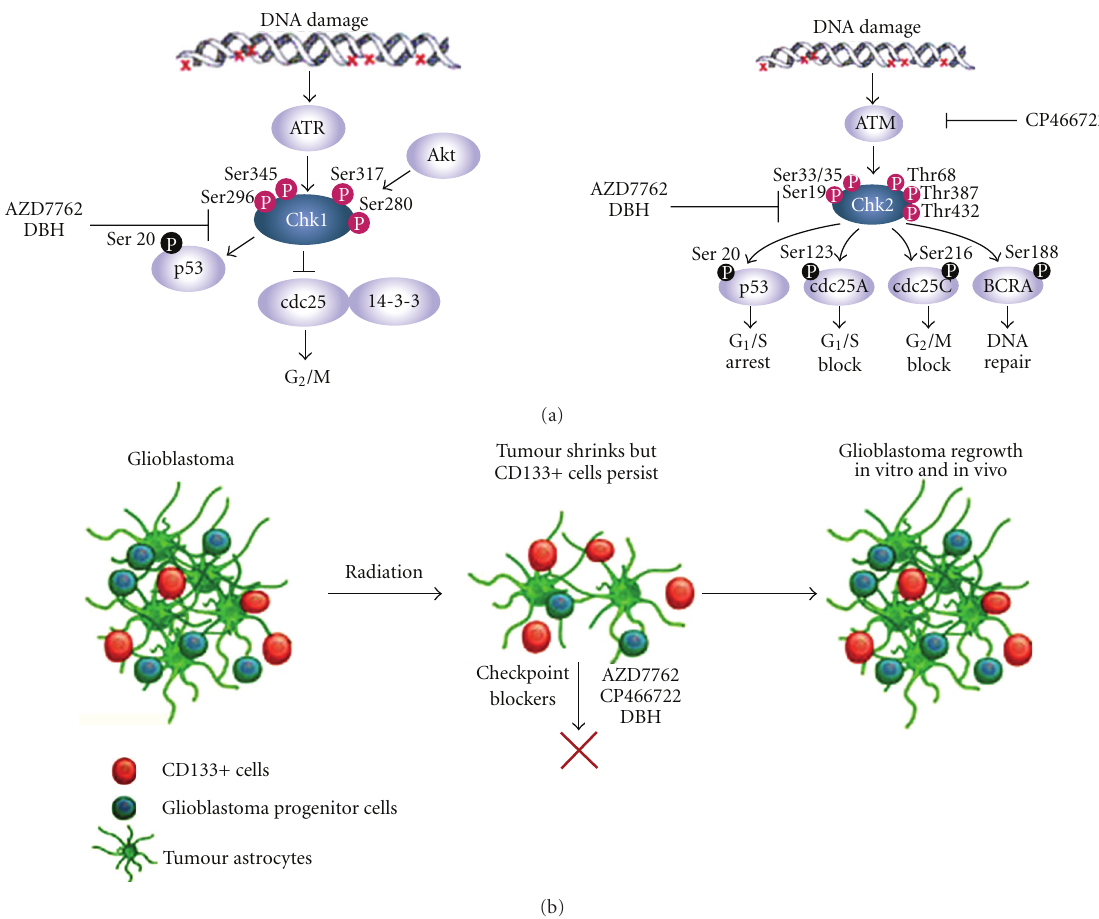
Figure 3: Cell cycle checkpoint pathways, possible targets in GSC. (a) Once DNA damage is identified with the aid of sensors, the checkpoint transducers ATM and ATR undergo conformational change and/or localisation, resulting in their activation. ATM and ATR activate a series of downstream molecules, including the checkpoint kinases Chk1 and Chk2. The latter inactivate CDC25 phosphatases, culminating in cell cycle arrest. AZD7762 (AstraZeneca) and DBH are specific inhibitors of Chk1 and Chk2 kinases. CP466722 (Pfizer) is a specific inhibitor of ATM (modified from [82] with permission). (b) Targeting GSC may yield durable tumor regression. Glioblastomas are heterogeneous tumours containing CD133-positive GSC among other, more di ff erentiated, CD133-negative cells, including glioblastoma progenitor cells. Following radiation, the bulk glioblastoma responds and the tumour shrinks but CD133-positive cells activate checkpoint controls for DNA repair more strongly than CD133-negative cells, resist radiation and prompt the tumour to regrow. These cells could be targeted with DNA- checkpoint blockers (e.g., AZD7762, CP466722 and DBH) to render them radiosensitive (modified from [83] with